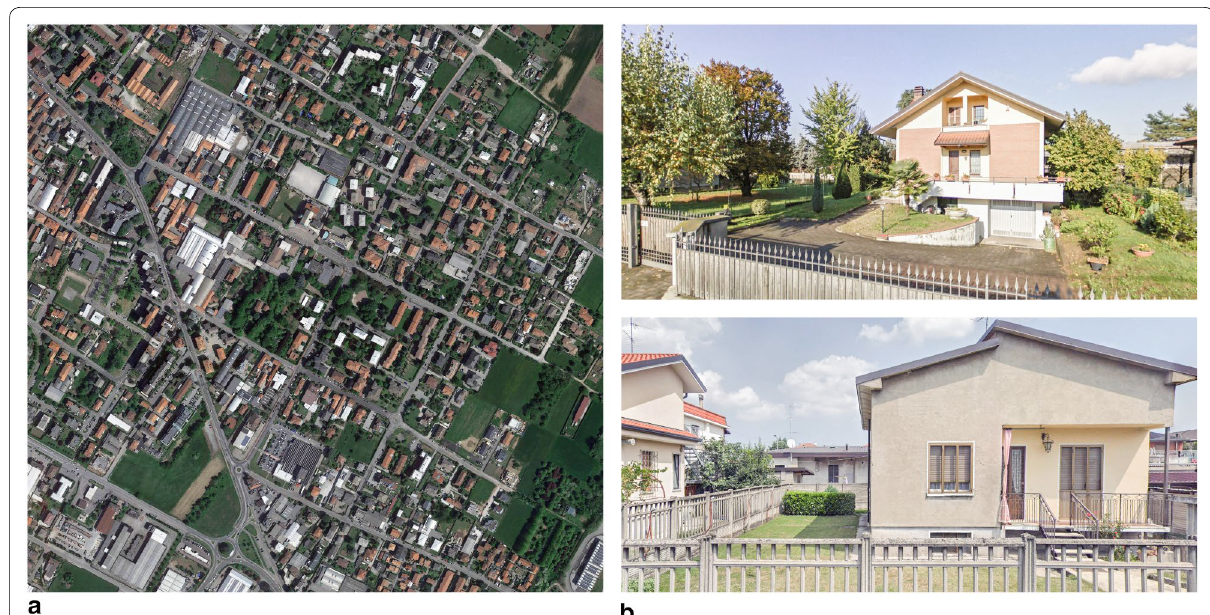
Fig. 5 a Municipality of Mariano Comense, 1 1 km sample. Fabrics of Family houses (Google Earth). b Municipality of Mariano Comense and × Seveso-Barruccana, villette (Google Street